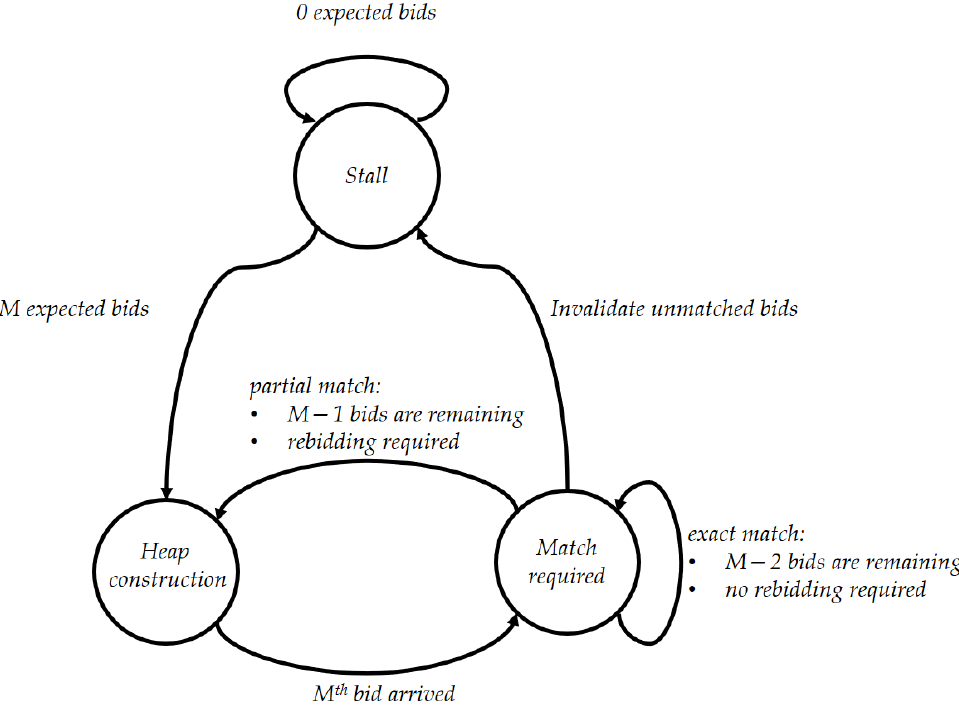
Figure 6. Finite State